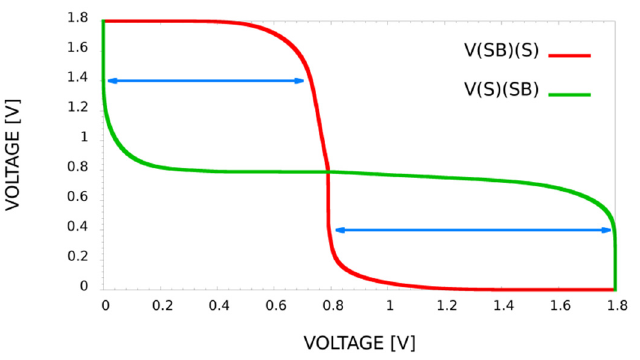
Figure 12. Effect of the R3 defect on SNM.